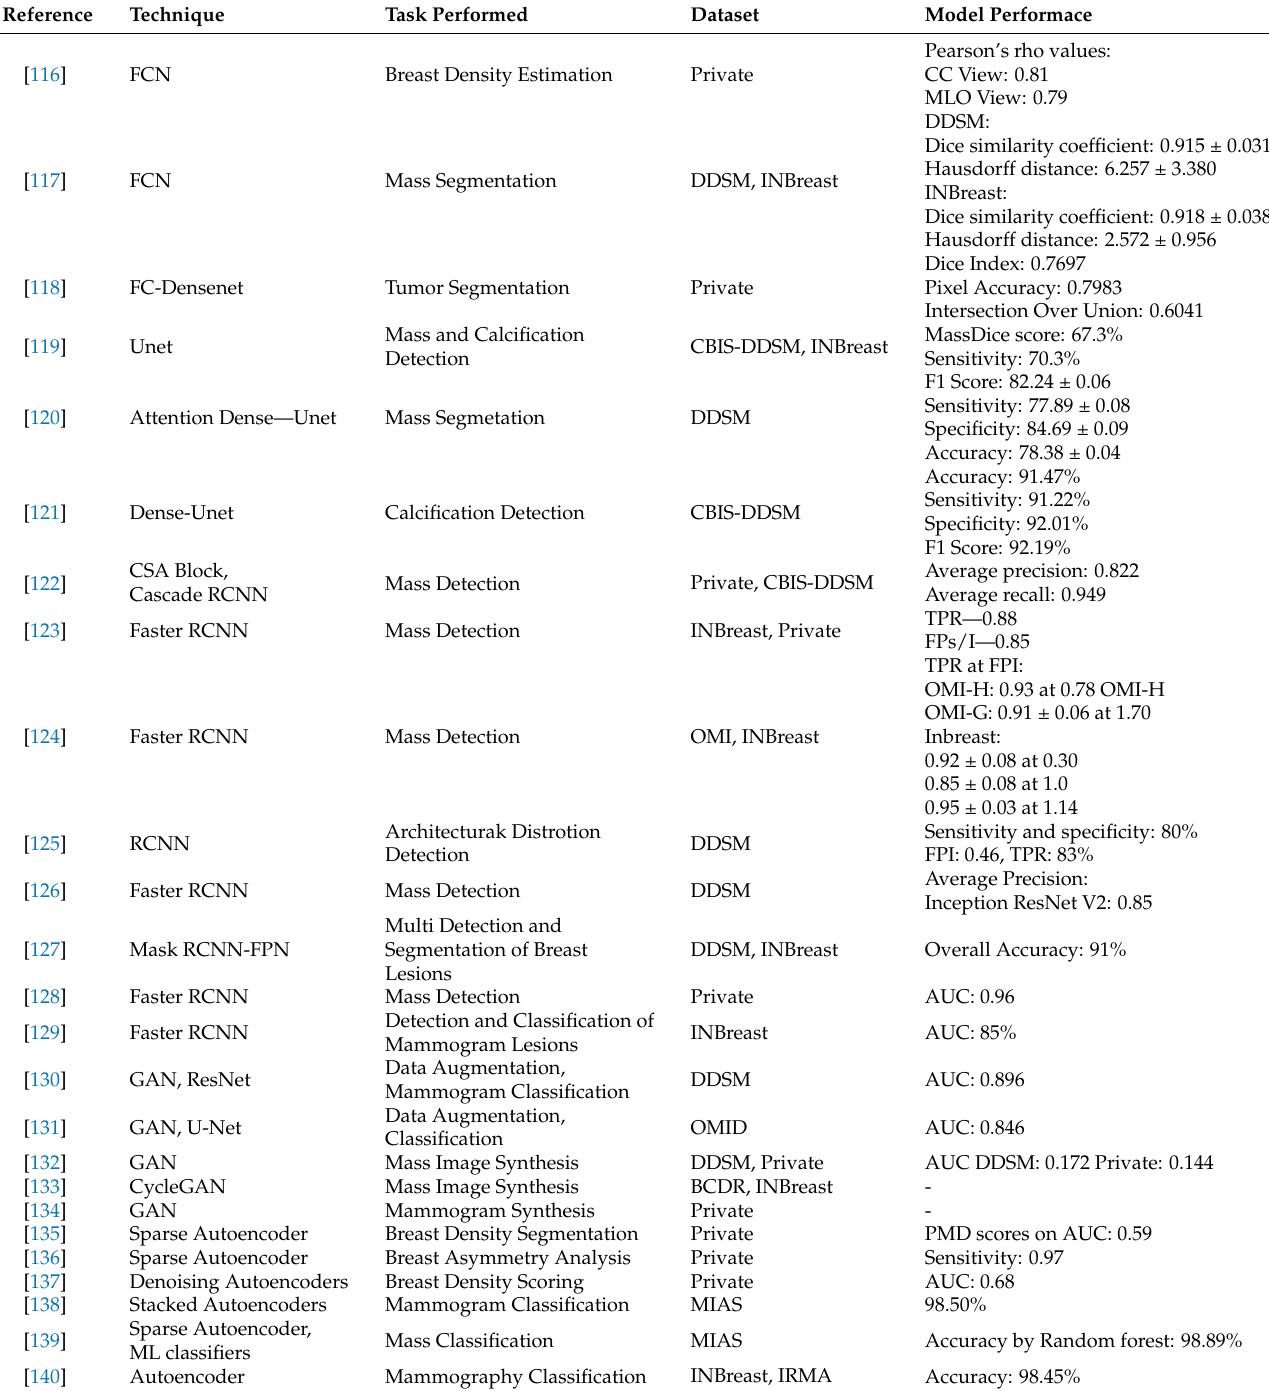
Table 5. Deep learning approaches for breast cancer